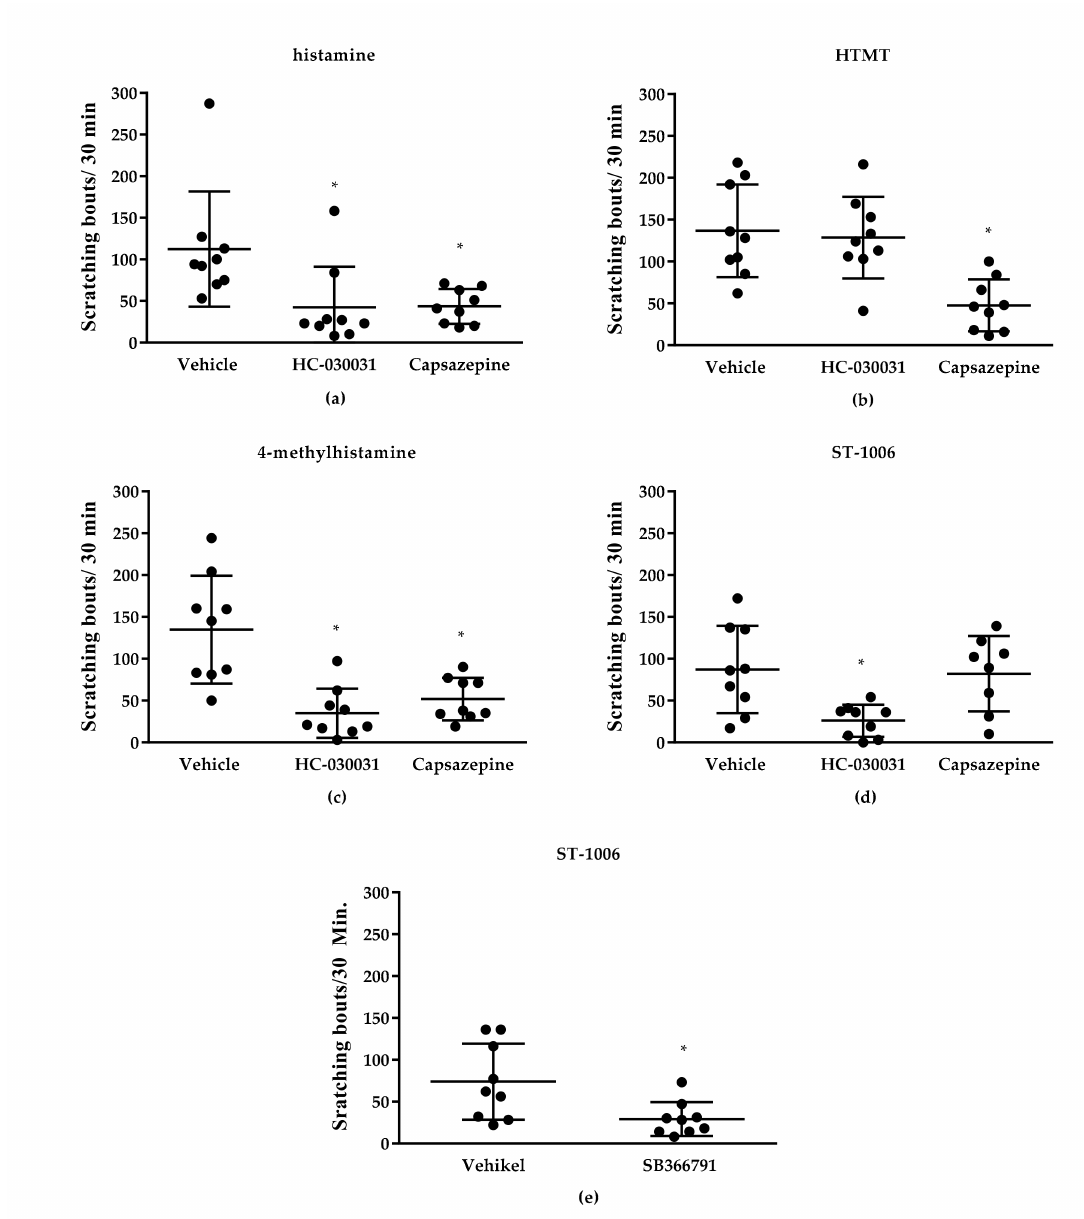
Figure 4. Influence of the TRPA1 inhibitor HC-030031 and the TRPV1 inhibitor capsazepine or SB366701 on histamine- induced itch in CD-1 mice. ( a ) Histamine (all HR)-induced pruritus (25 nmol/L, i.d.) was significantly reduced by both tested inhibitors. ( b ) HTMT (H1R/H2R)-induced pruritus (100 nmol/L, i.d.) was significantly reduced by capsazepine. ( c ) 4-MH (H2R/H4R)-induced pruritus (50 nmol/L, i.d.) was significantly reduced by both tested inhibitors. ( d ) ST-1006 (H4R)-induced pruritus (50 nmol/L, i.d.) was significantly reduced by HC-030031. ( e ) ST-1004 (H4R)-induced pruritus (50 nmol/L i.d.) was significantly reduced by SB366791. Observation time: 30 min. Results are displayed as scatter-dot plots with median ± SD. n = 9 ( n = 8 for ST-1006 + capsazepine—exclusion of one mouse due to stereotypical behavior during video monitoring). * p < 0.05 (Mann–Whitney U test) = significantly different from vehicle. Dose per 200 µ L i.p. injection of inhibitors: HC-030031: 60 mg/kg, capsazepine: 6 mg/kg, SB366791: 0.5 mg/kg, vehicle = 10%